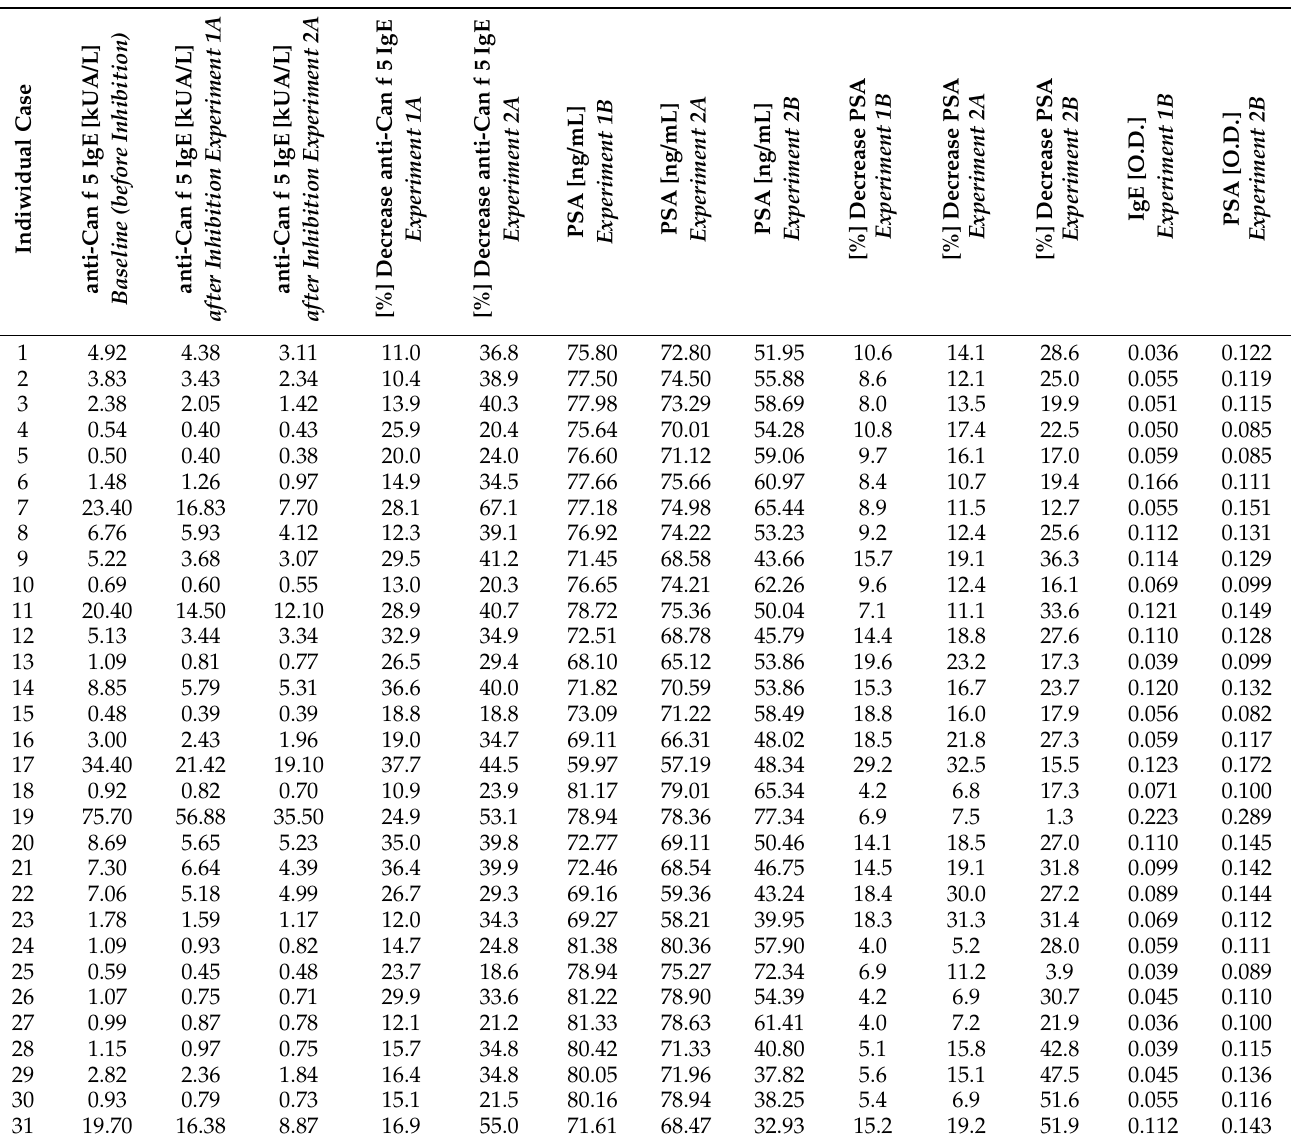
Table 1. The results of both models inhibition tests in each individual case.